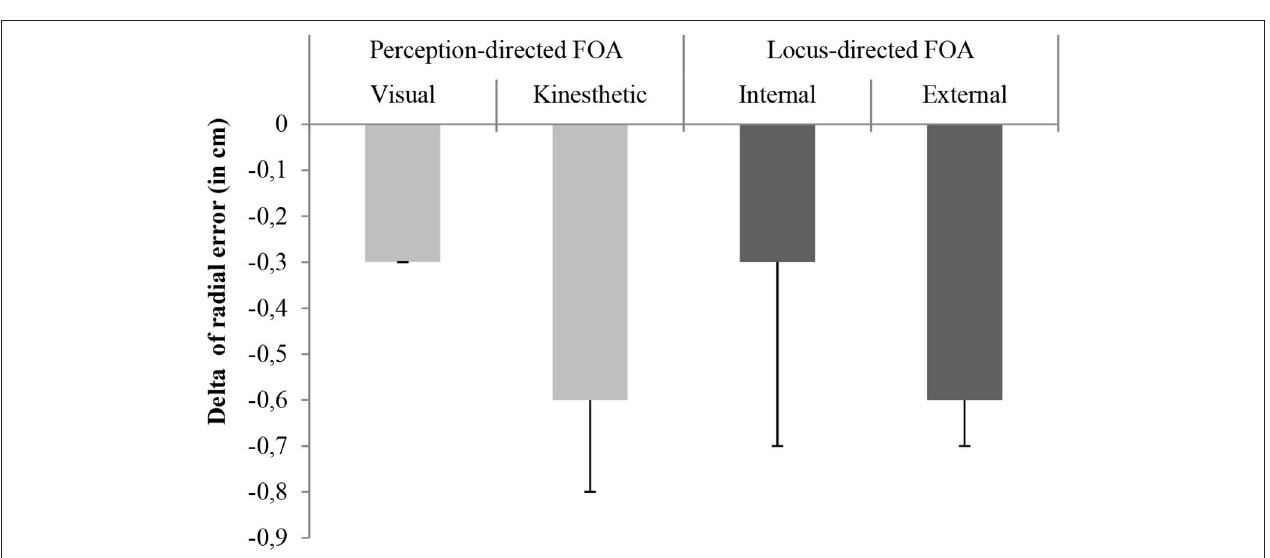
FIGURE 2 | Mean values representing the reduction of radial error in throwing accuracy between pre- and posttest ( 1 ) with error bars representing the standard deviation.